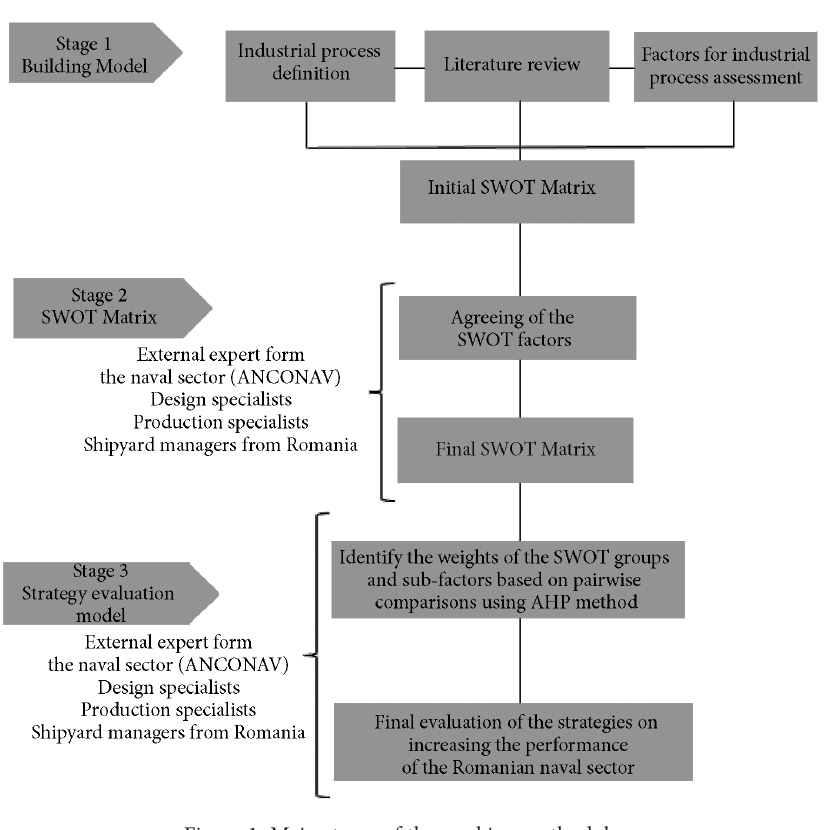
Figure 1. Main stages of the working